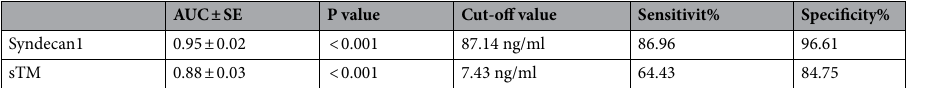
Table 4. Receiver operating characteristic (ROC) analysis for Syndecan1 and sTM in Septic shock. sTM serum thrombomodulin.